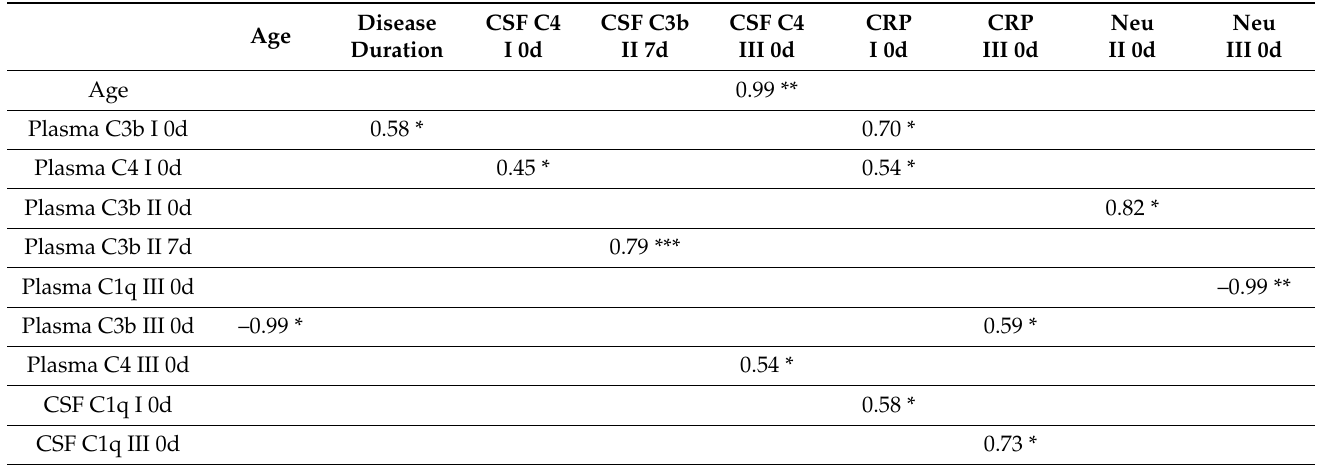
Table 2. Correlation analysis between selected factors using Spearman’s correlation rank test. Age